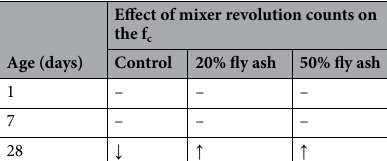
Figure 10a,b show the effects of mixing time and mixer revolution counts on the D a of the control, 20%, and 50% fly ash systems, respectively. Results indicate that neither mixing time nor mixer revolution counts has a significant effect on the D a for all systems (ANOVA p-value > 0.05). The control